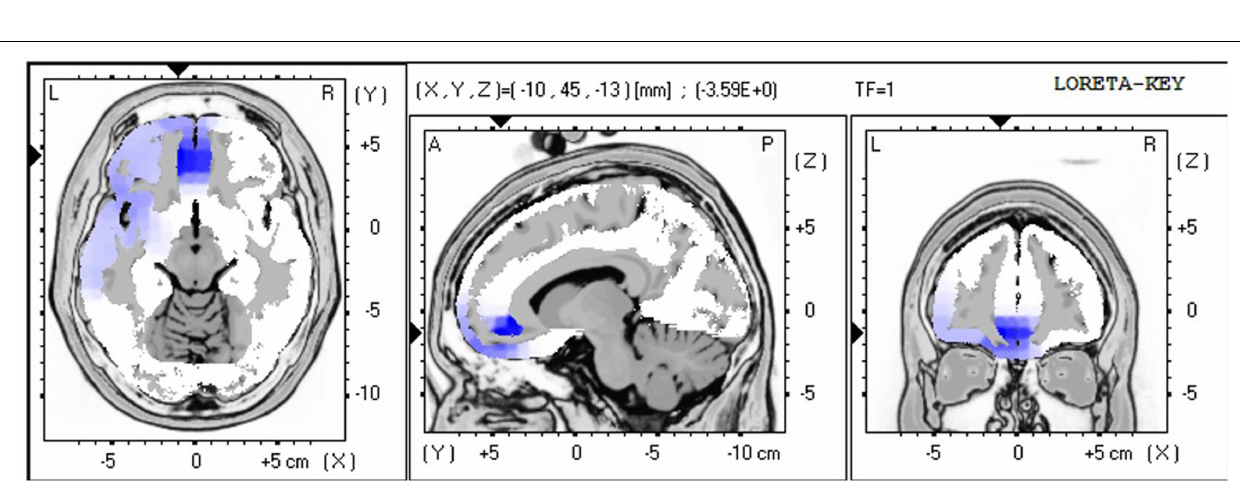
2002), and inferior temporal lobe (Bokura et al., 2001). The